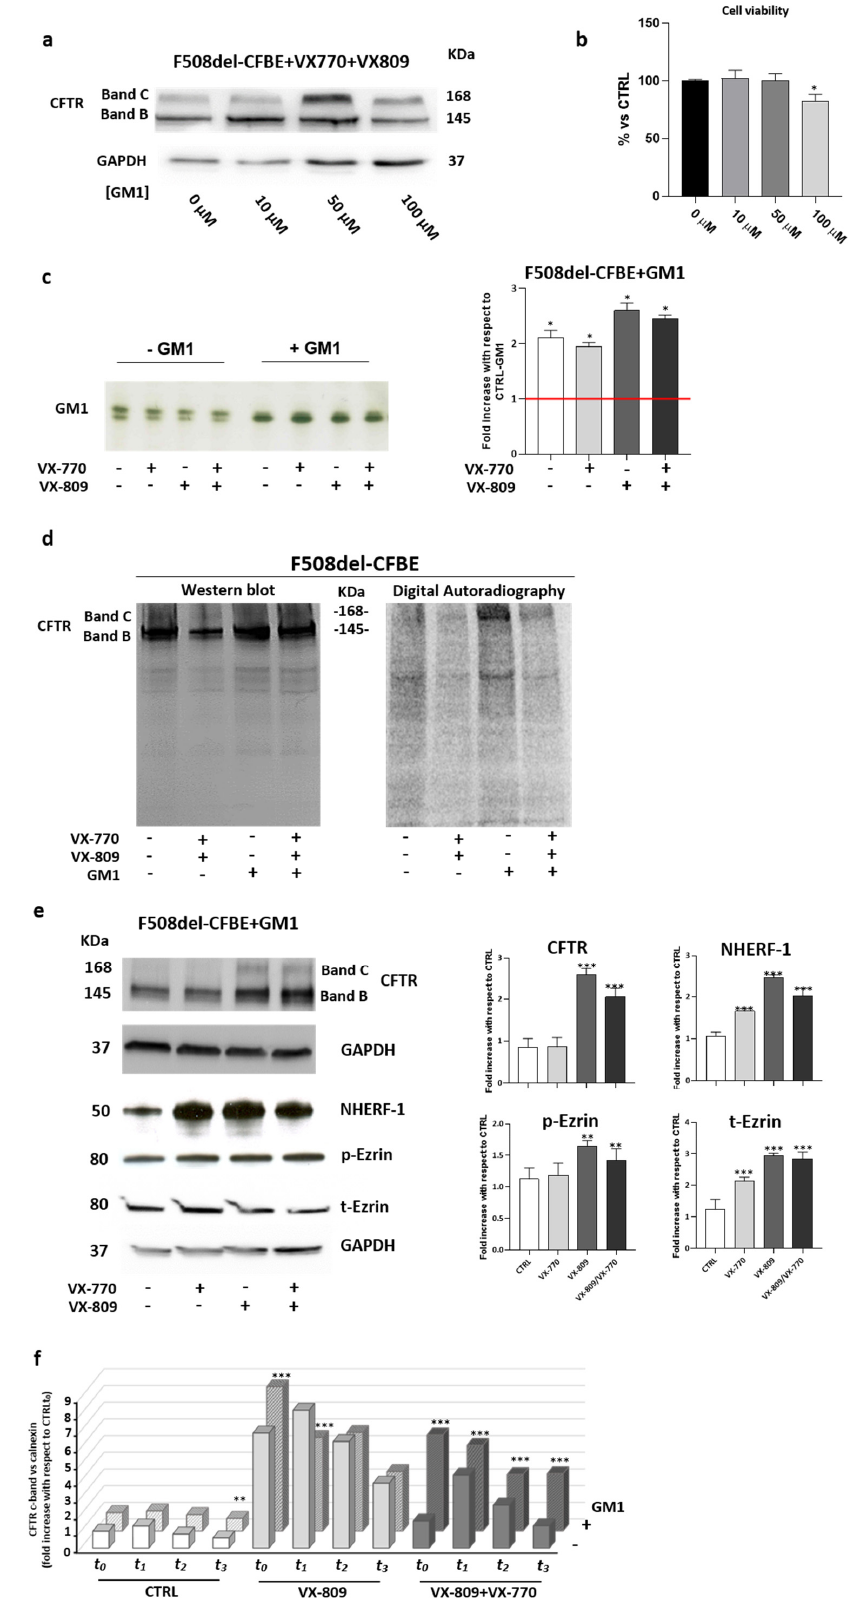
Figure 4. Restoring the GM1 content in bronchial epithelial cells compensates for the adverse e ff ect of VX-770 on the plasma membrane stability of F508del CFTR. ( a ) Representative western-blot